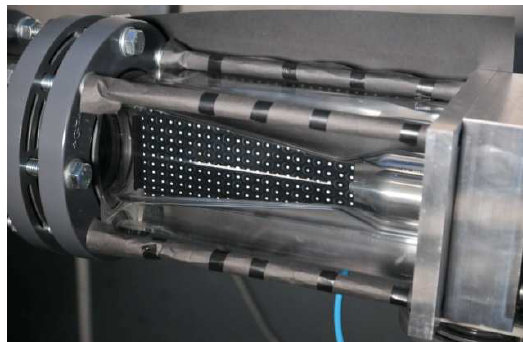
Fig. 1b. Used multi-level PIV